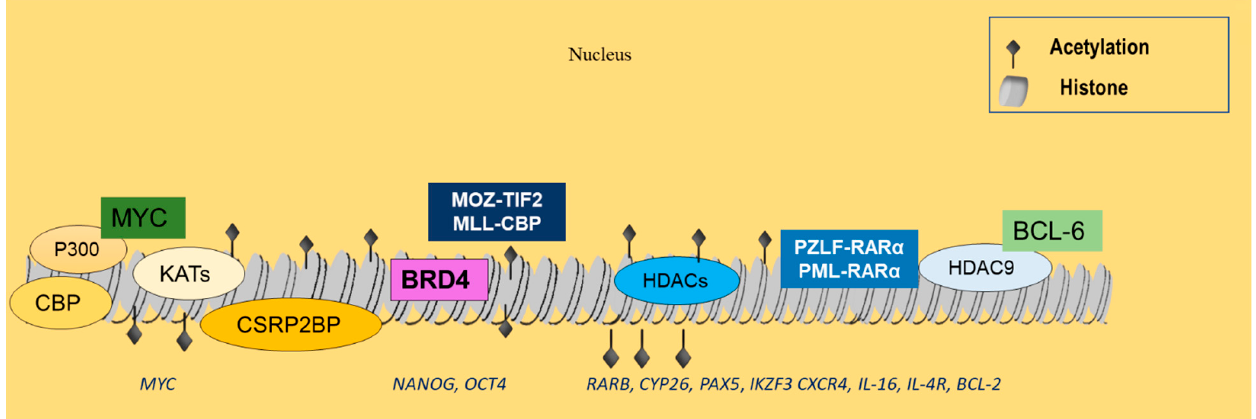
Figure 2. Histone acetylation events related to hematological malignancies. CBP and p300 are often dysregulated in lymphoid neoplasms, leading to abnormal acetylation of histones, as well as nonhistone targets, such as BCL-6 and p53 . KAT7, KAT2A, KAT6B, and CSRP2BP are overexpressed in B-ALL and may interact with MYC, implicating them in tumor development. BRD4 further associates with p300/CBP-mediated acetylation-enhanced regions, controlling genes associated with cell renewal and pluripotency, such as Nanog and OCT4 . MOZ-TIF2 and MLL-CBP are commonly rearranged in myeloid malignancies, resulting in the respective FPs that have been implicated in leukemic transformation. Increased HDAC expression is also common in ALL, regulating RARb, CYP26 Pax5, IKZF3, CXCR4, IL-16, IL-4R , and Bcl-2 gene expression. HDACs, and in particular HDAC9, also interact with the PML-RAR α and PLZF-RAR α FPs, as well as with BCL-6 to promote the development of hematologic malignancies.